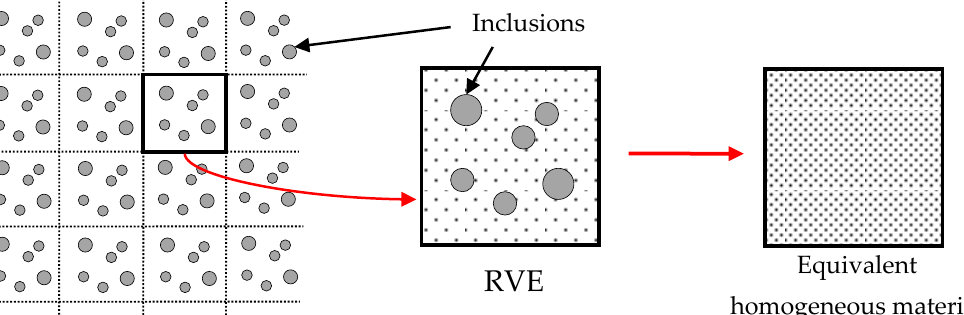
Figure 6. Schematic of representative volume element (RVE) method.